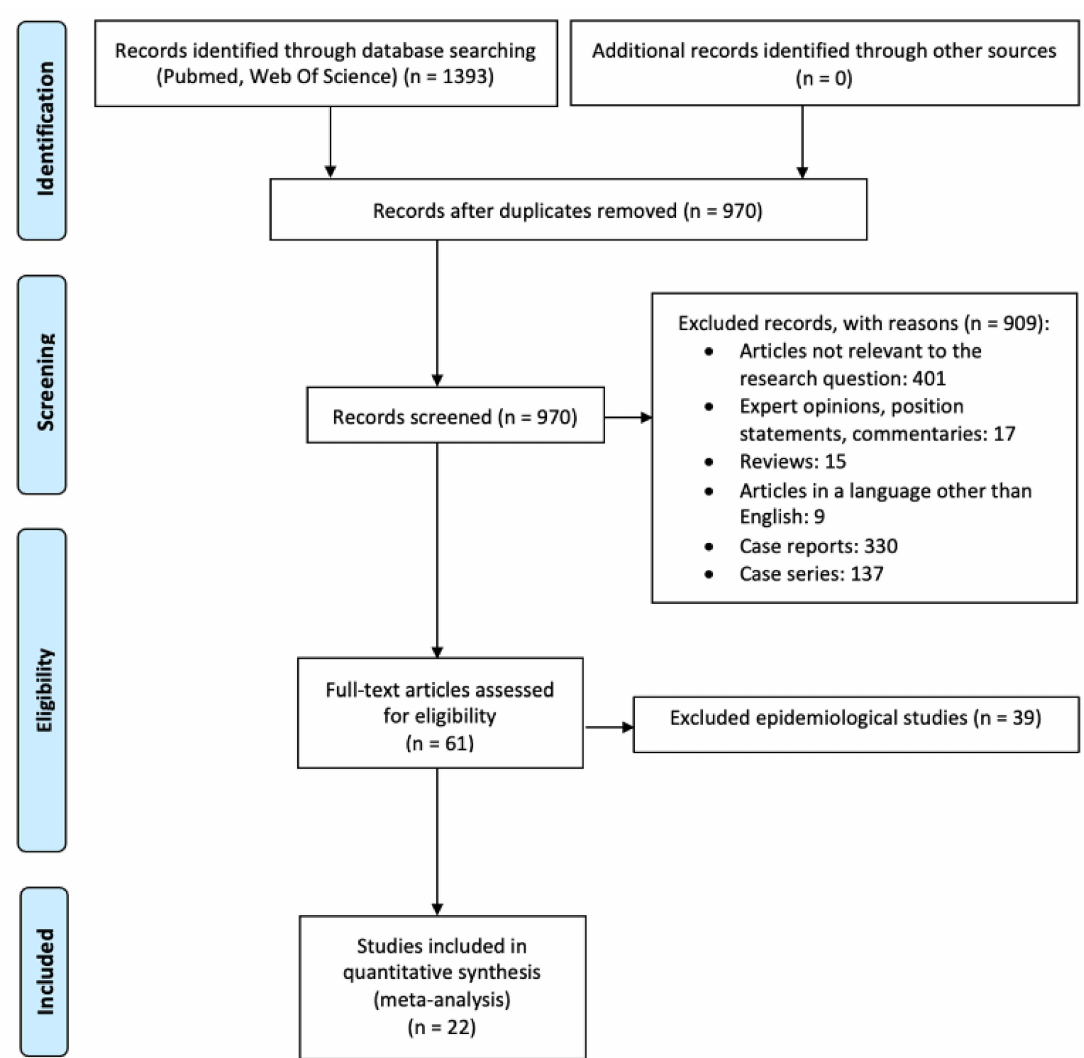
Figure 1. PRISMA Study Flow Chart describing the screening procedure of the articles included in the